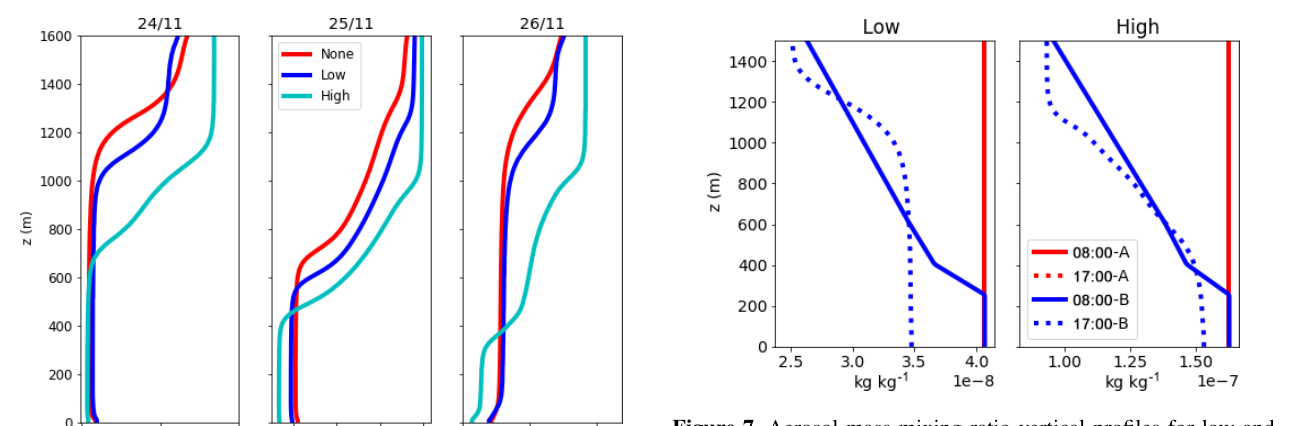
Figure 7. Aerosol mass mixing ratio vertical profiles for low and high aerosol loading simulations on 26 November, for constant aerosol profile (red) and vertically varying aerosol profiles (blue) at initial time step (solid) and after 9h simulation (dashed). For the case of the constant vertical profiles (red lines), the aerosol mass mixing ratio remains constant through time and so the dashed red lines are hidden behind the solid red